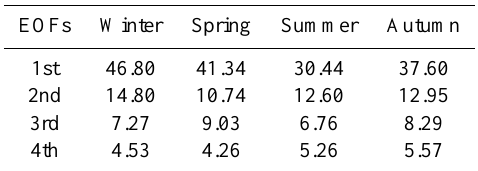
Table 2. Percentages of explained variance for each unrotated EOF for seasonal data.